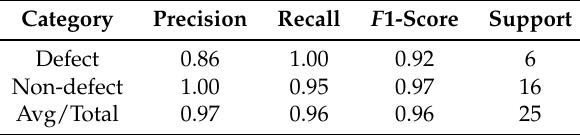
Table 1. Random Forest Validation